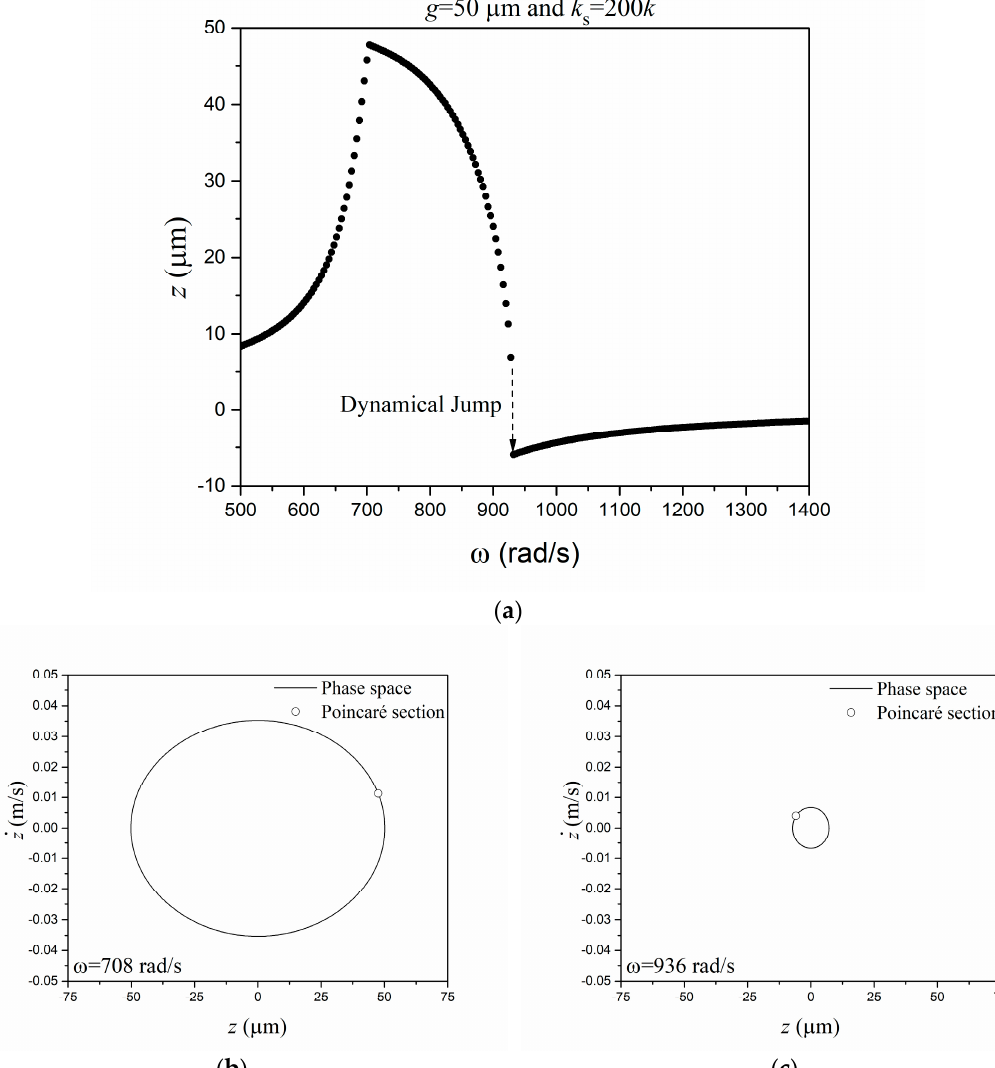
Figure 11. ( a ) Bifurcation diagram for g = 50 μ m and β = 200. Phase space and Poincaré sections for ( b ) ω = 708 rad/s and ( c ) ω = 936 rad/s.